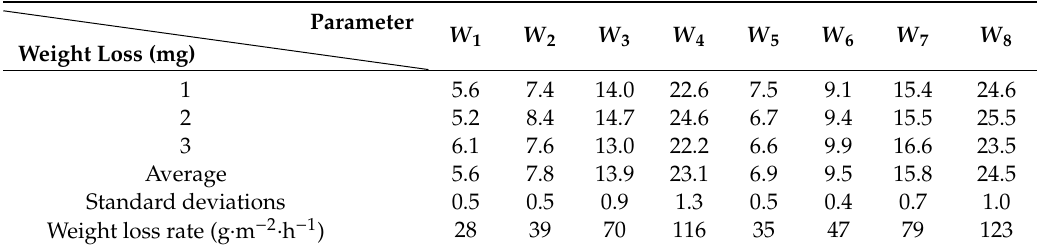
Table 4. Loss rates under the eight conditions.